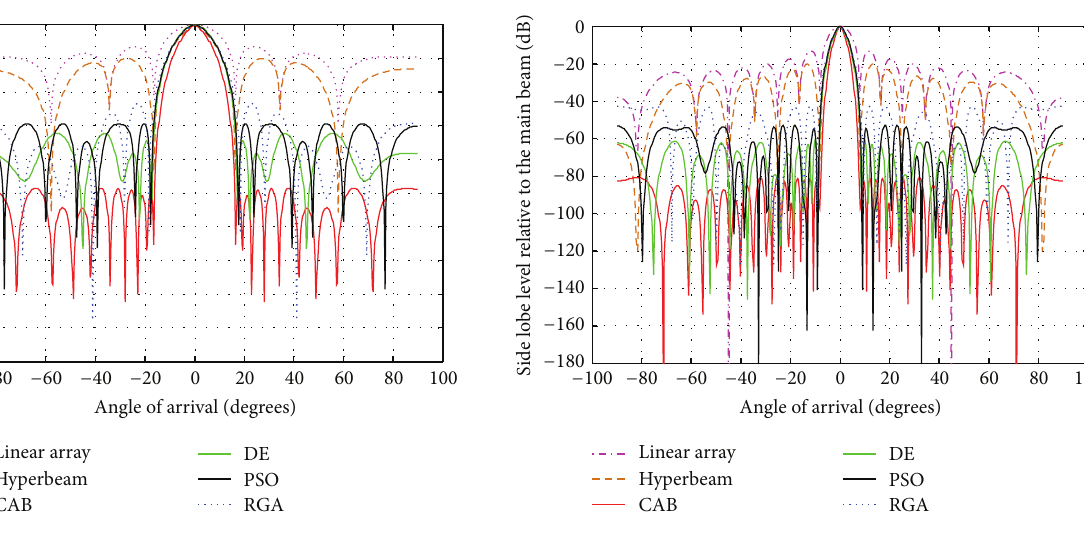
Figure 7: Best array pattern found by CAB for the 10-element array at 𝑢 = 1 with improved SLL.